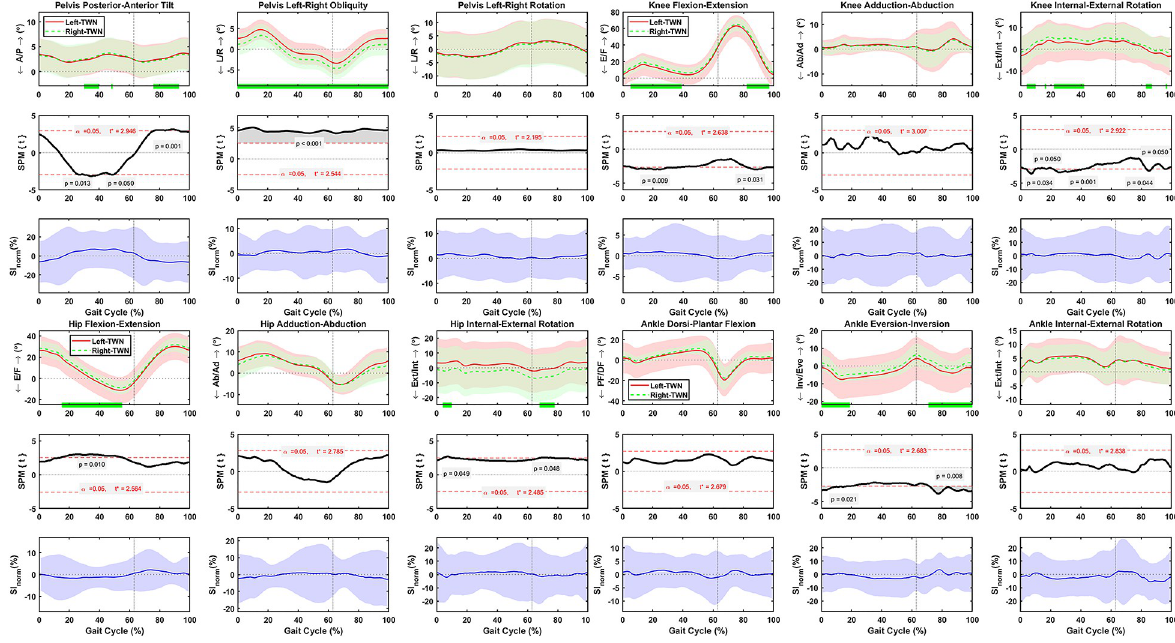
Fig 5. Average and standard deviation of pelvis posterior-anterior (P/A) tilt, left-right(L/R) obliquity, and (L/R) rotation, hip and knee flexion-extension (F/E), adduction-abduction (Ad/Ab), and internal-external (Int/Ext) rotation, and ankle dorsi-plantar flexion (DF/PF), eversion-inversion (Eve/Inv), and internal-external (Int/Ext) rotation for left and right sides during one gait cycle of normal treadmill walking (TWN) in sixty healthy participants. Green bars on the horizontal axis and the scalar field SPM results with threshold t � t depict where, in % cycle, left side angles were greater or lesser than right side angles. The normalized symmetry index (SI norm ) calculated during one gait cycle of TWN. Solid and dashed lines correspond to average left and right sides, as well as average SI norm , and shaded areas correspond to standard deviation. Black dotted vertical lines denote